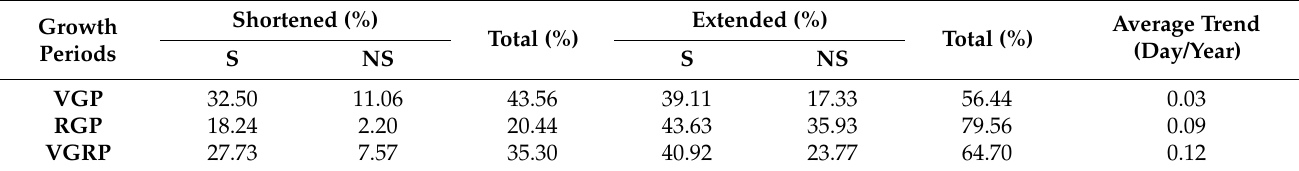
Table 3. Proportion of shortened and extended lengths for different growth periods.